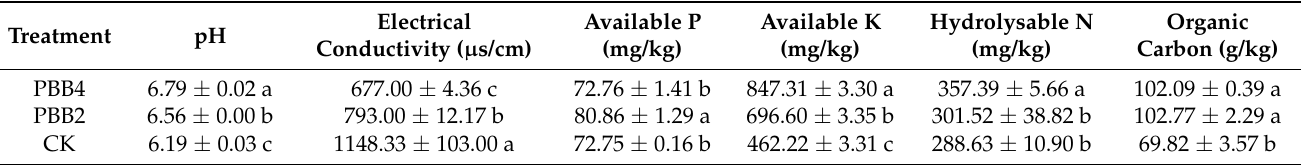
Table 3. Effects of bio-organic fertilizer treatment on soil chemical properties.